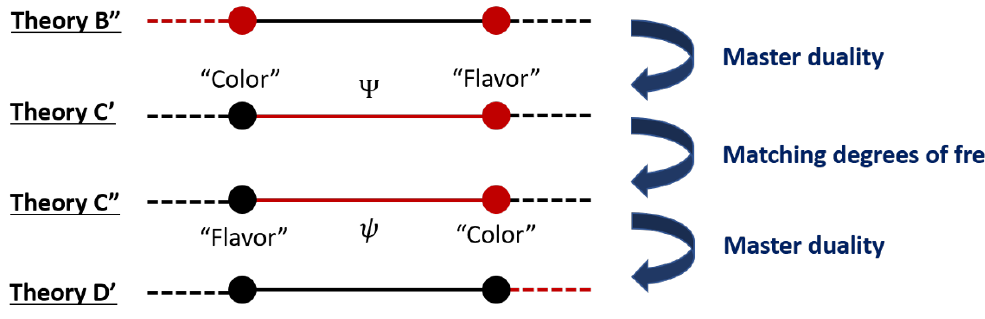
Figure 5 . How the matching occurs on a generic internal link, which for the purposes of concrete- ness we have labeled C’ and